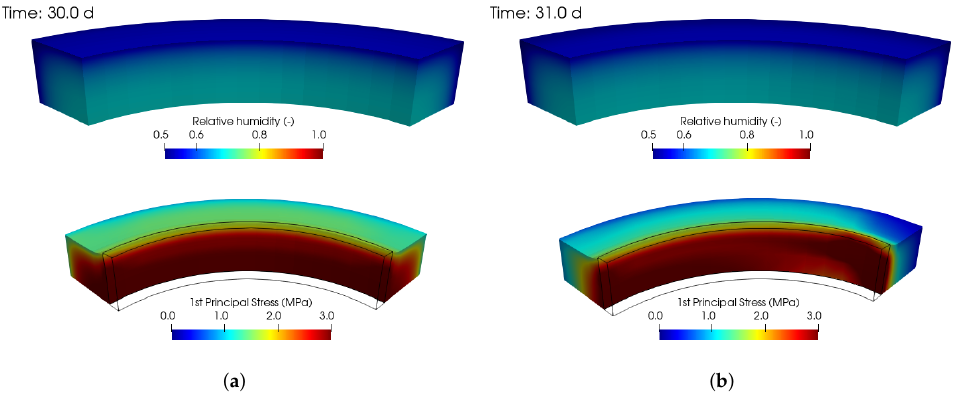
Figure 11. Hygro-mechanical simulation of 1/8 of the ring test. Relative humidity and the first principal stress before cracking ( a ) and after cracking ( b ). Deformations exaggerated 250 ×